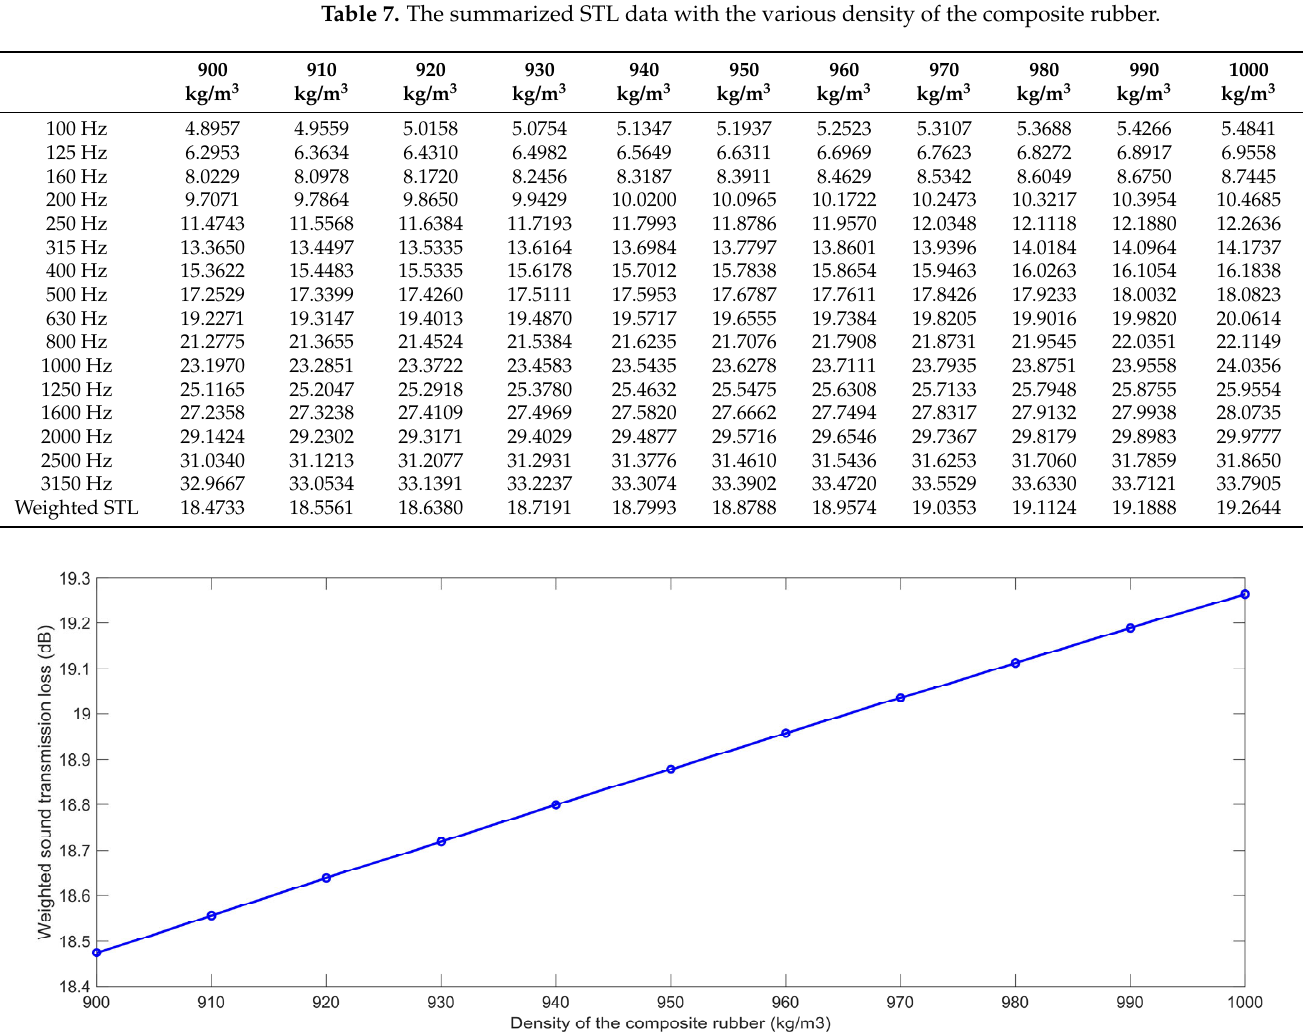
Table 7. The summarized STL data with the various density of the composite rubber.